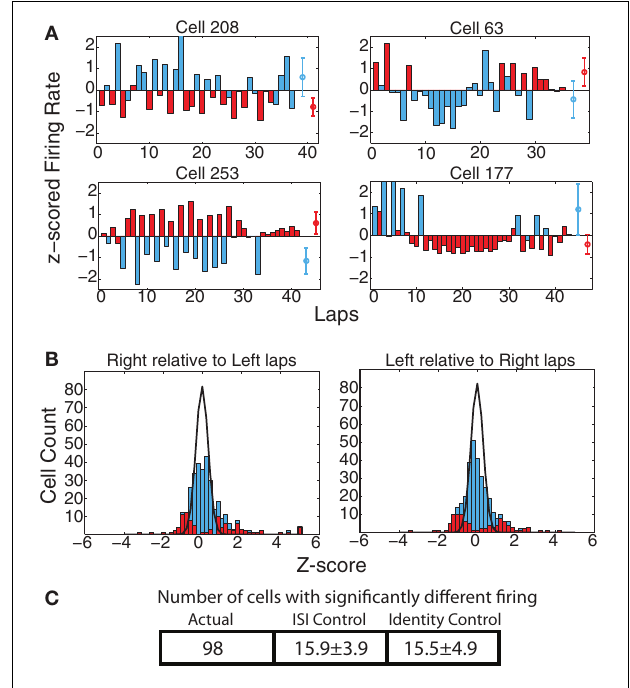
FIGURE 7 | (A) Examples of cells with strong changes in firing rate on laps to the left vs. to the right of the track. Red bars indicate laps run to the right, blue bars laps run to the left. Red and blue circles represent average firing rates over both types of laps. (B) z right (left) and z left (right) comparisons. Bars indicate overall distribution, with red bars indicating cells found to have a significant firing difference by KS test. Black line indicates expected distribution from ID shuffle. (C) Number of cells with significantly different firing (by KS test of the distribution of firing rates on laps to the left compared to the right) relative to expected number of cells from two control conditions with inter-spike-intervals (ISI) or lap identity (ID) randomly